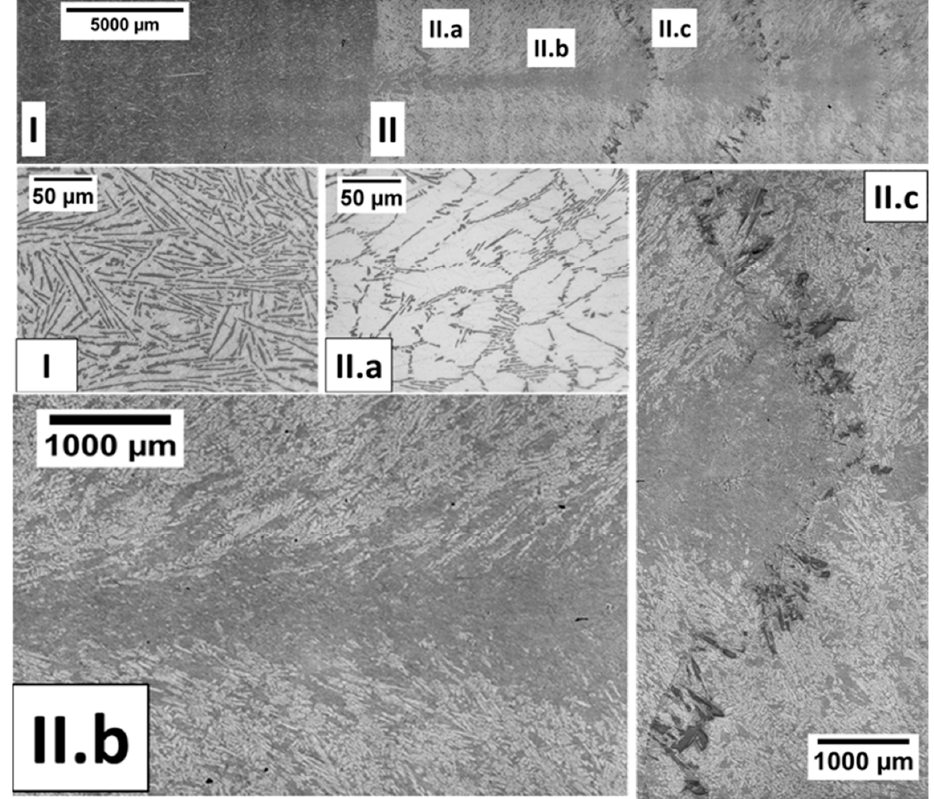
Figure 11. The micrograph photo of sample C shows ( I ) a pure irregular Al-Si eutectic structure in step 1 and ( II ) a solidified structure in step 2 when 100 mT magnetic field is applied, including ( II.a ) primary aluminum with inter-dendritic eutectic structure at the sample edges. ( II.b ) a eutectic struc- ture solidified as CTL segregation pattern with sidearm freckles. ( II.c ) Primary silicon arc-like col- ony.